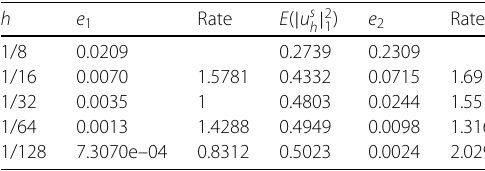
h e 1 Rate E ( | u s